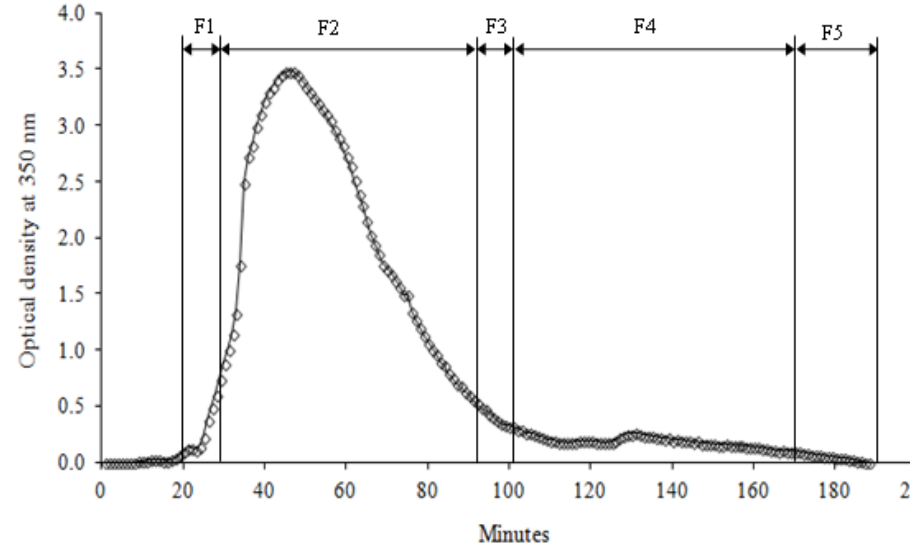
Figure 2. Size exclusion chromatograms of CTs from L. leucocephala fractionated using Sephadex G-25. The detector was set to 350 nm and the elution time was over 200 min. Fractions were combined according to their absorbance.